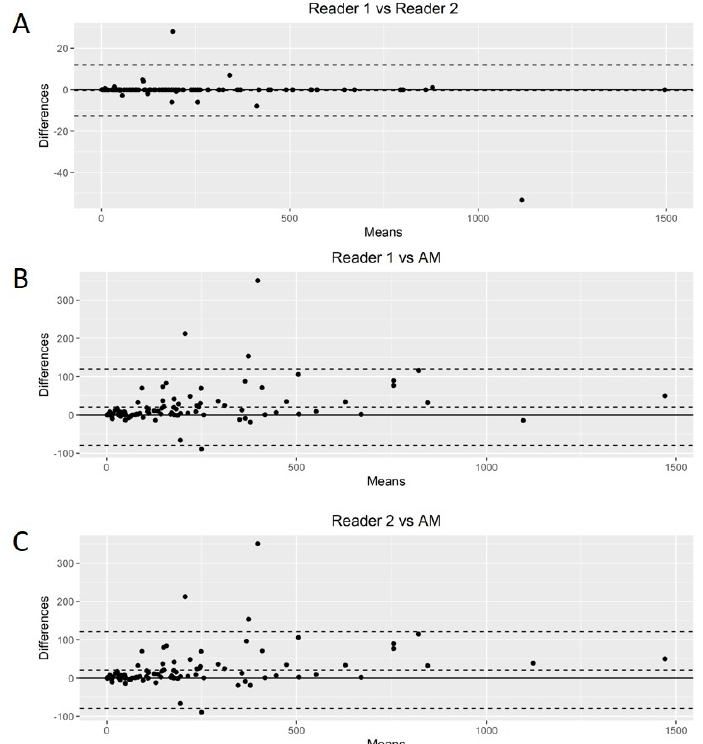
Figure 4. Bland–Altman plot. Graphical display for bias between two readers and automated method (AM) in metabolic tumor volume calculation ( A – C ).